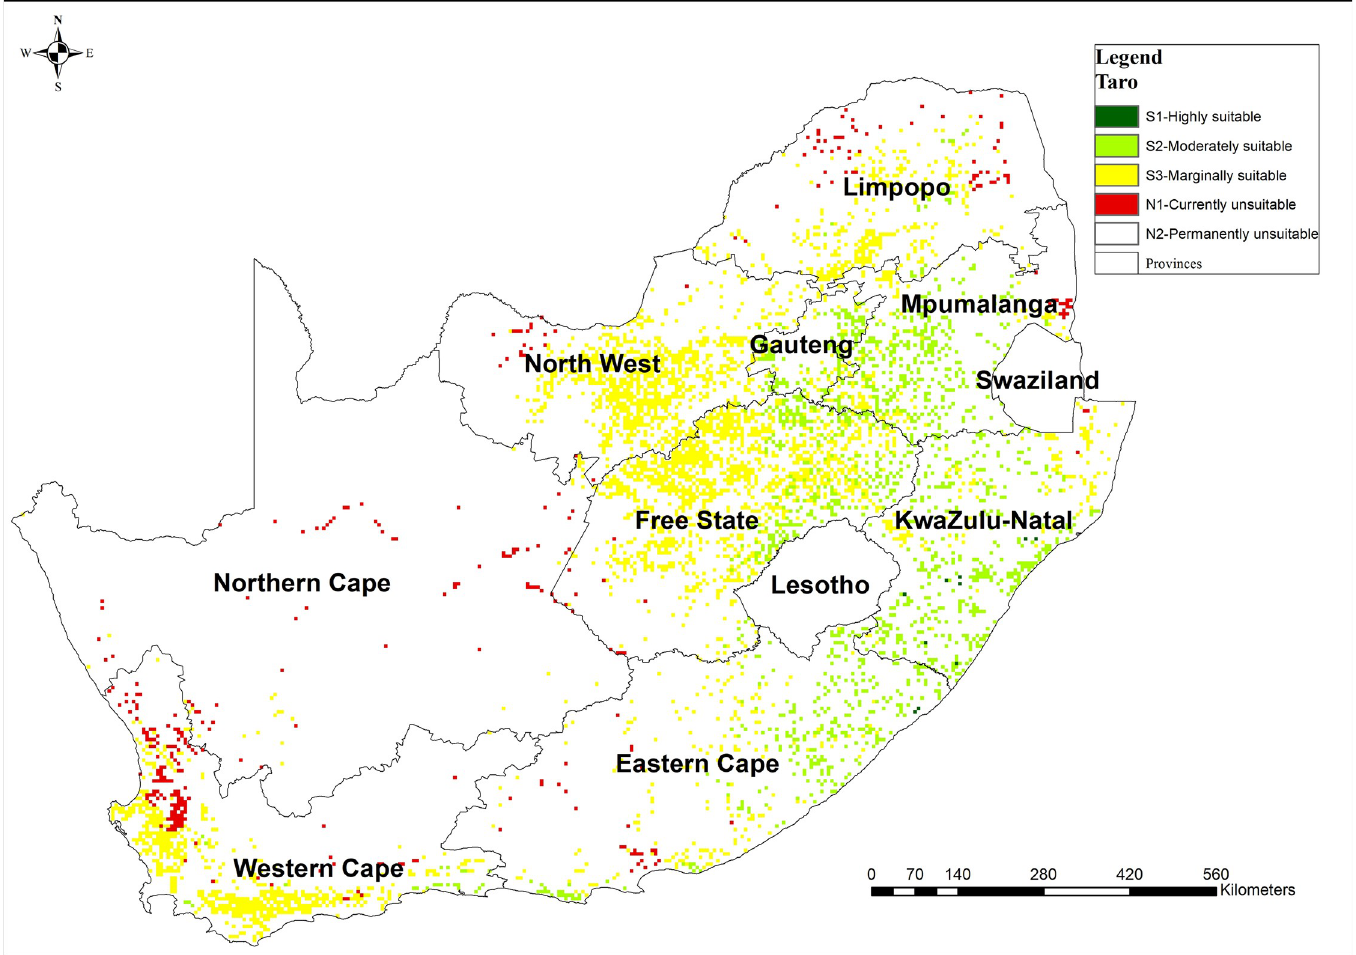
Fig 4. Suitability map for taro production in South Africa computed using MCDA-AHP and OWA operators [Source, South African Quaternary Catchments database , ( https://doi.org/10.6084/m9.figshare.13179881 ) , in ArcGIS 10 . 5] .